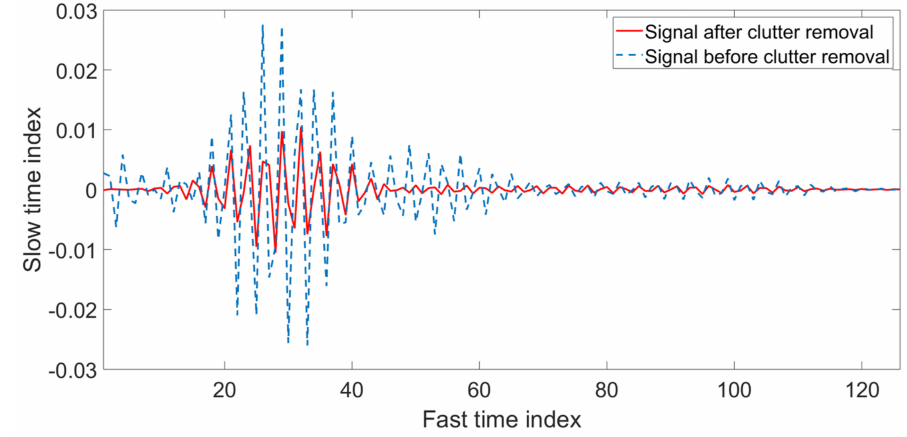
Figure 2. Received signal before and after clutter removal.